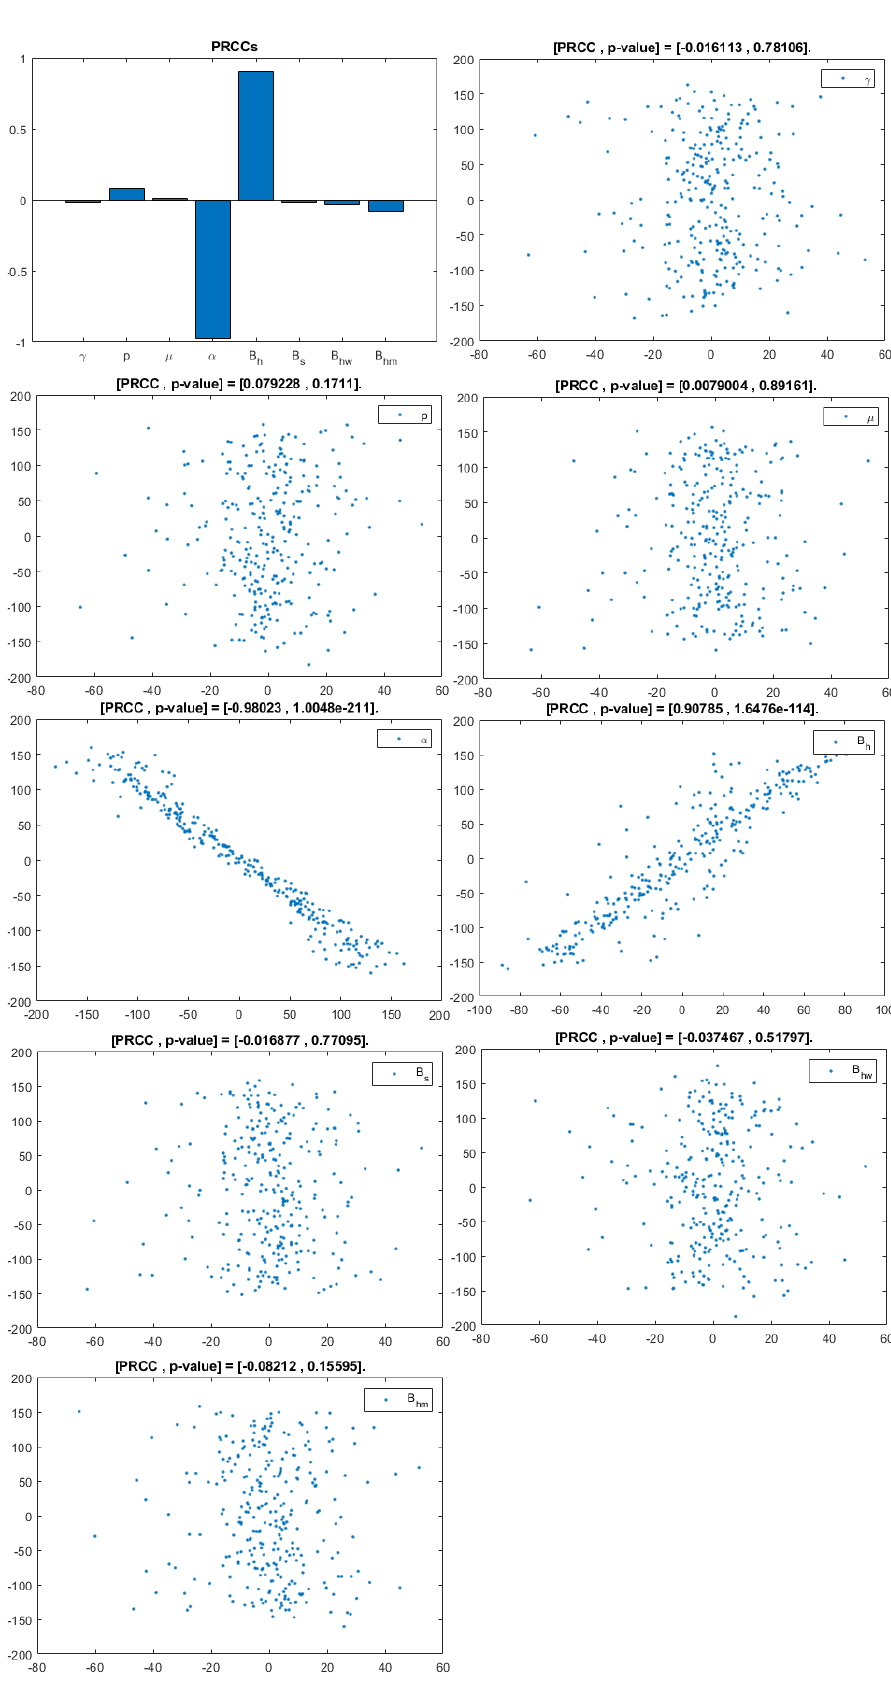
Figure 4. PRCC–Diagram and Scatterplot for each Parameter in Table 2 with respect to Untreated Infected Homosexual Men, I h